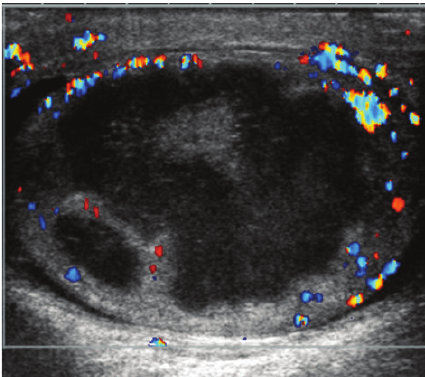
Figure 1: Scrotal ultrasound at presentation.